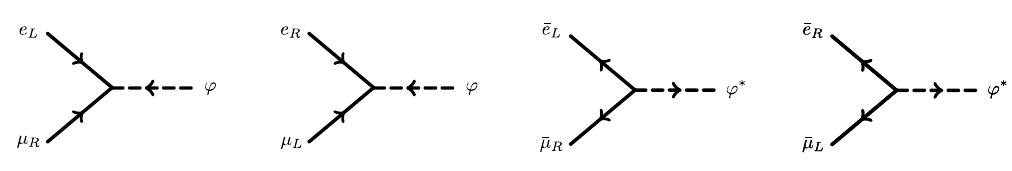
Figure 7 . Vertices from (B.3) to those in (B.4) where arrows on fermions represent helicity and the arrow on the scalar represents L e (cid:0) L (cid:22)